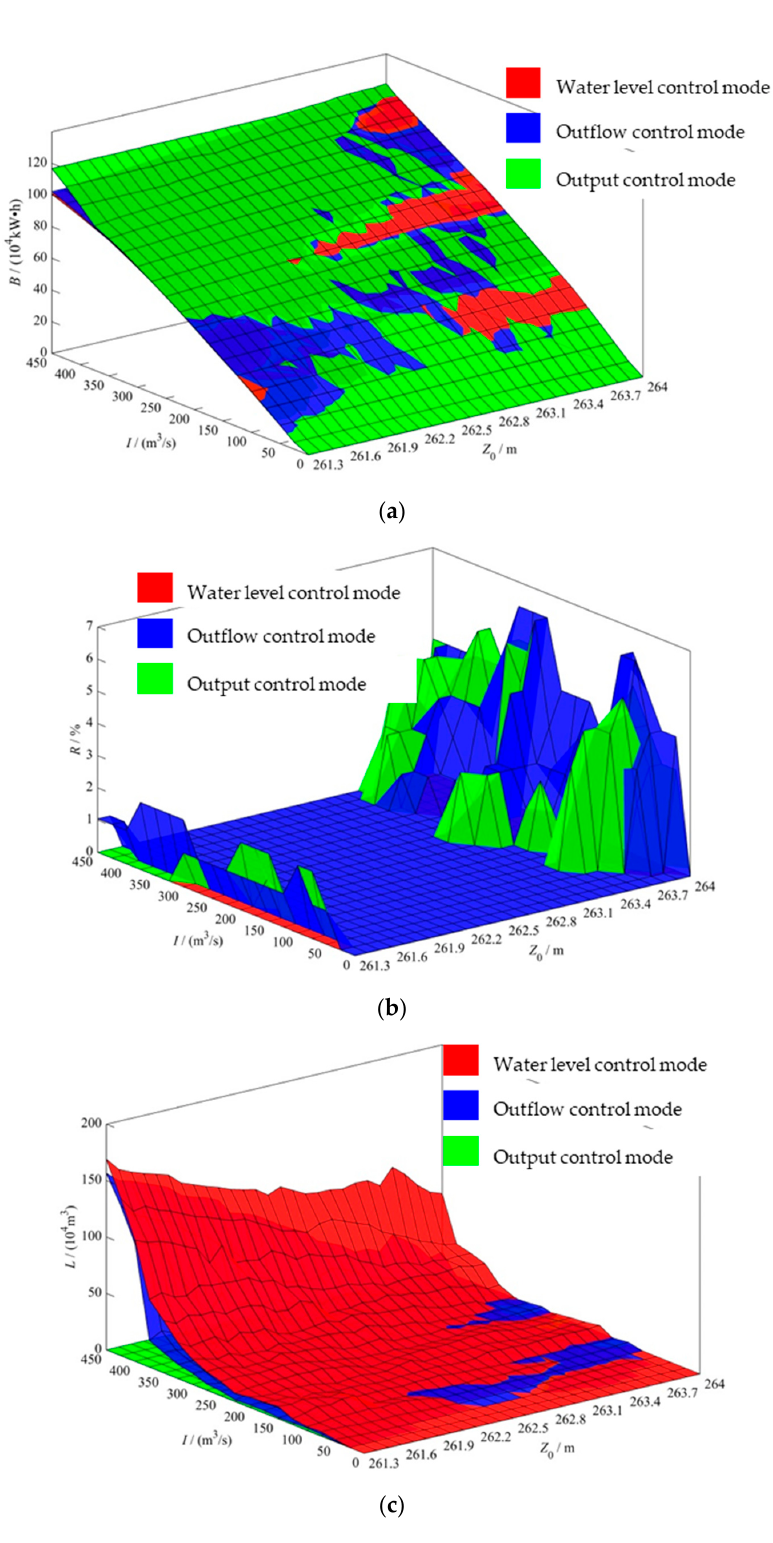
Figure 2. Calculation results of simulative operation. ( a ) Power generation benefits; ( b ) Risk rate of beyond-limit water level; ( c ) Discarded water.